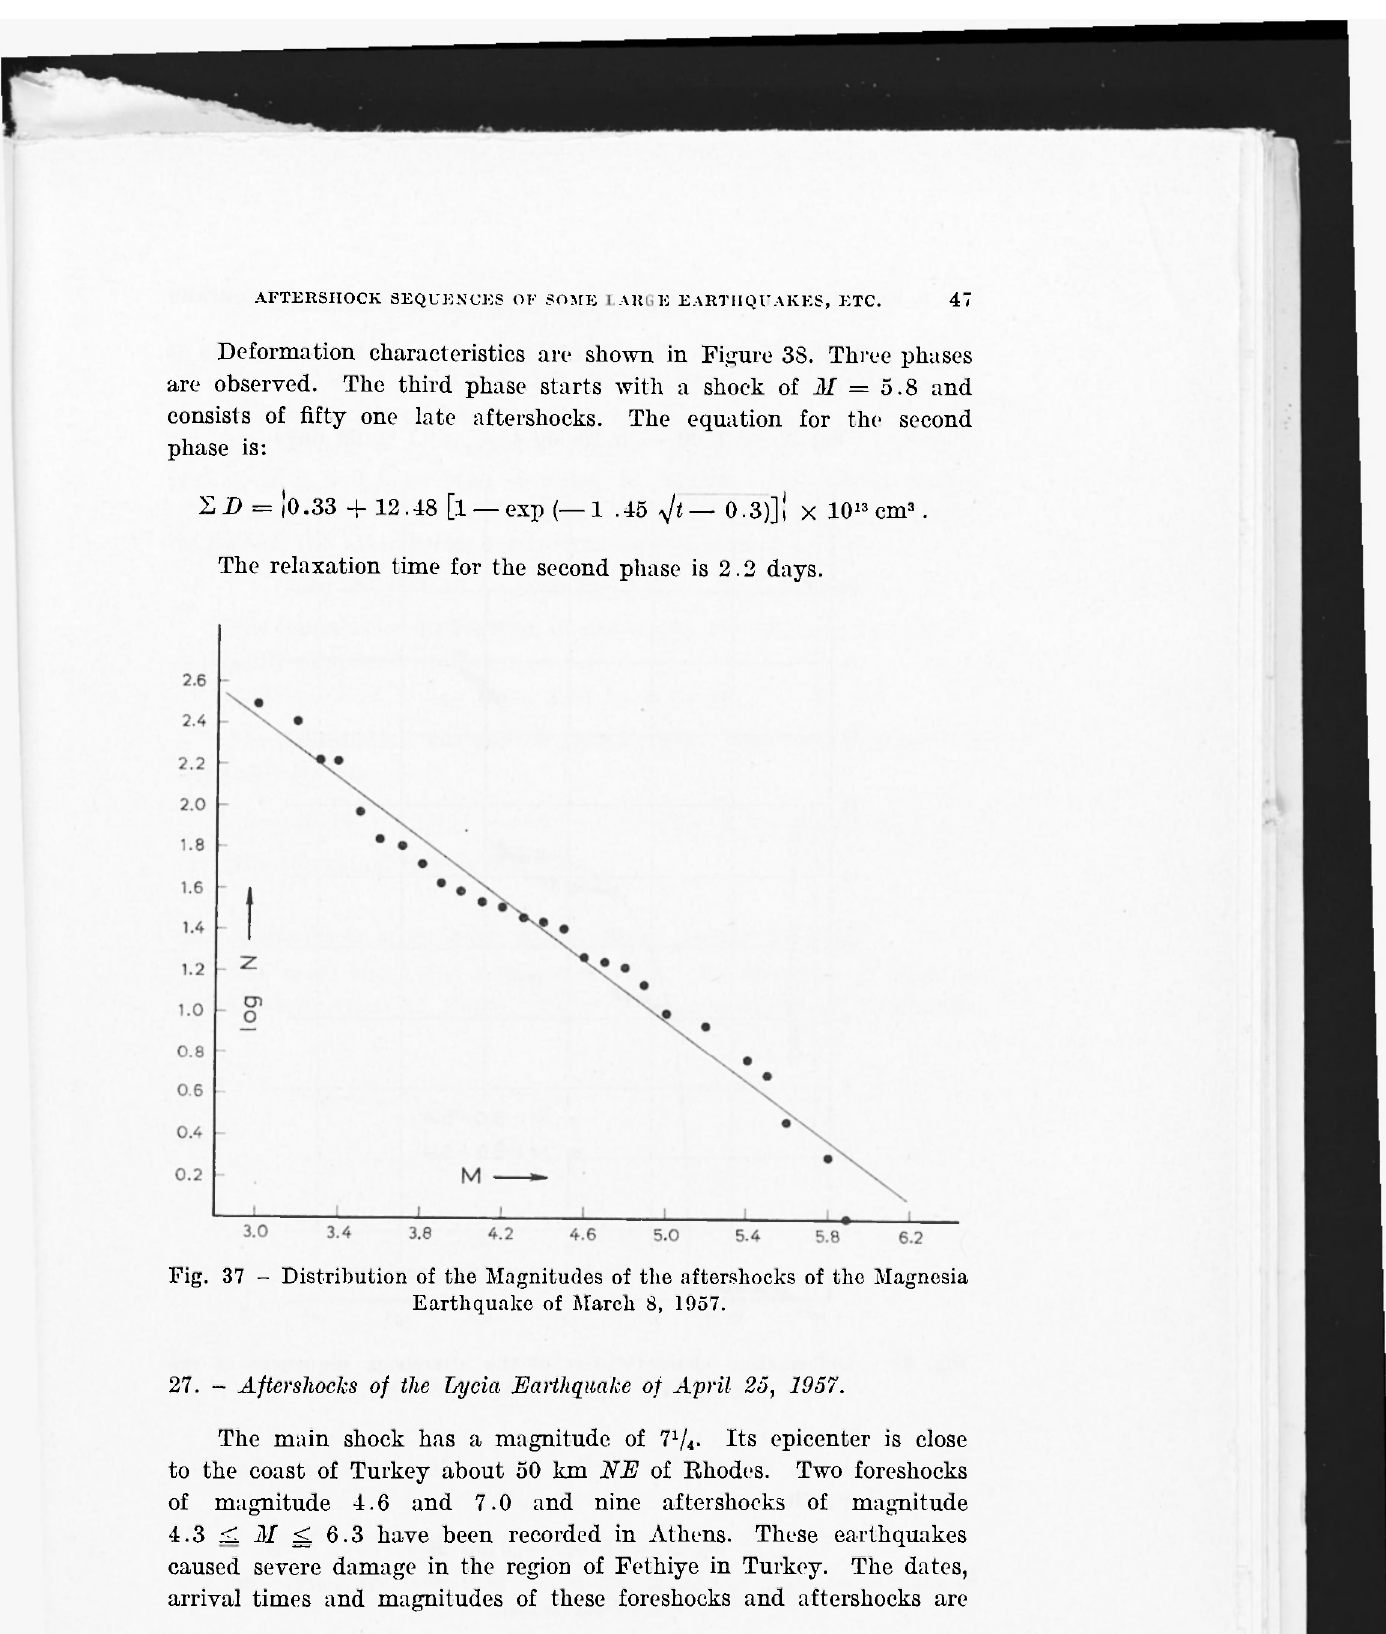
Fig. 37 - Distribution of the Magnitudes of the aftershocks of the Magnesia Earthquake of March 8,